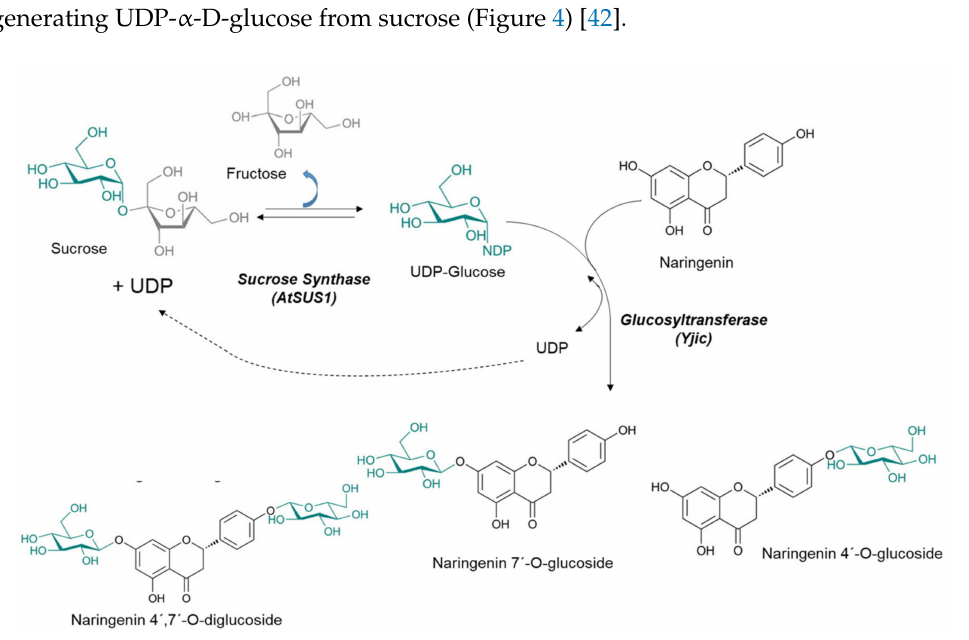
Figure 4. Synthesis of Naringenin-glycosylated flavonoids by multi-enzymatic cascade